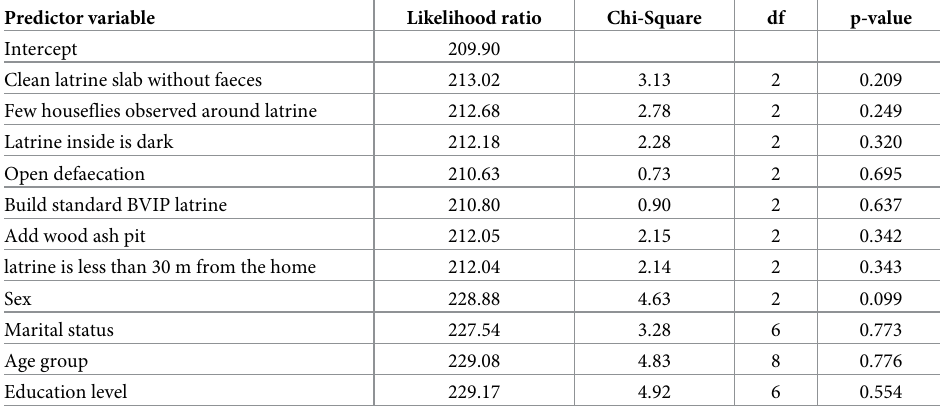
Table 2. Main effects of latrine